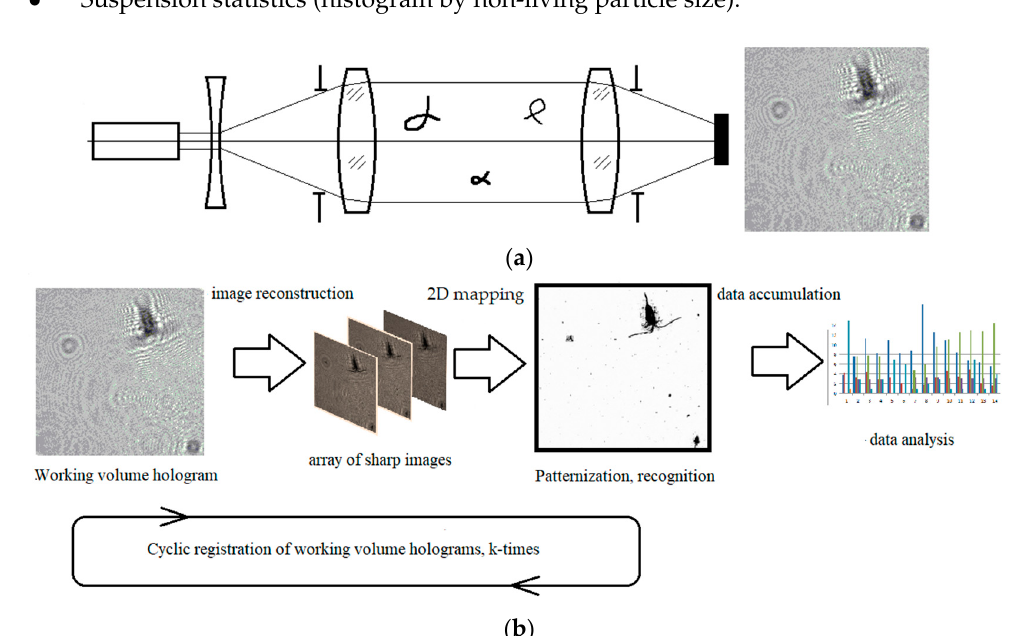
Figure 1. ( a )—Hologram recording by the miniDHC; ( b )—data extraction from a hologram for the analysis of plankton characteristics.